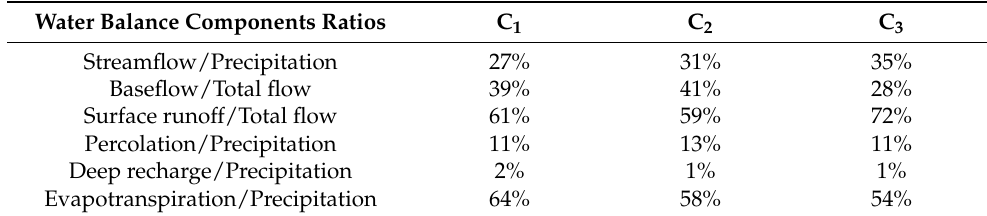
Table 5. Annual average water balance ratios among different hydrological cycle parameters based on SWAT outputs for all configuration periods.